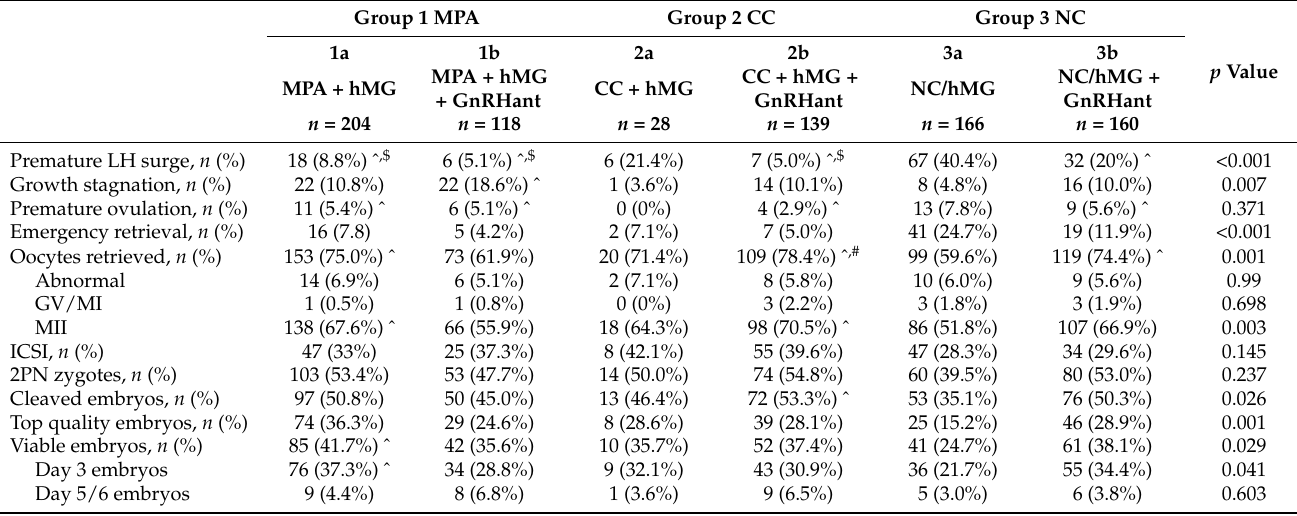
Table 2. Cycle characteristics and outcomes of oocytes and